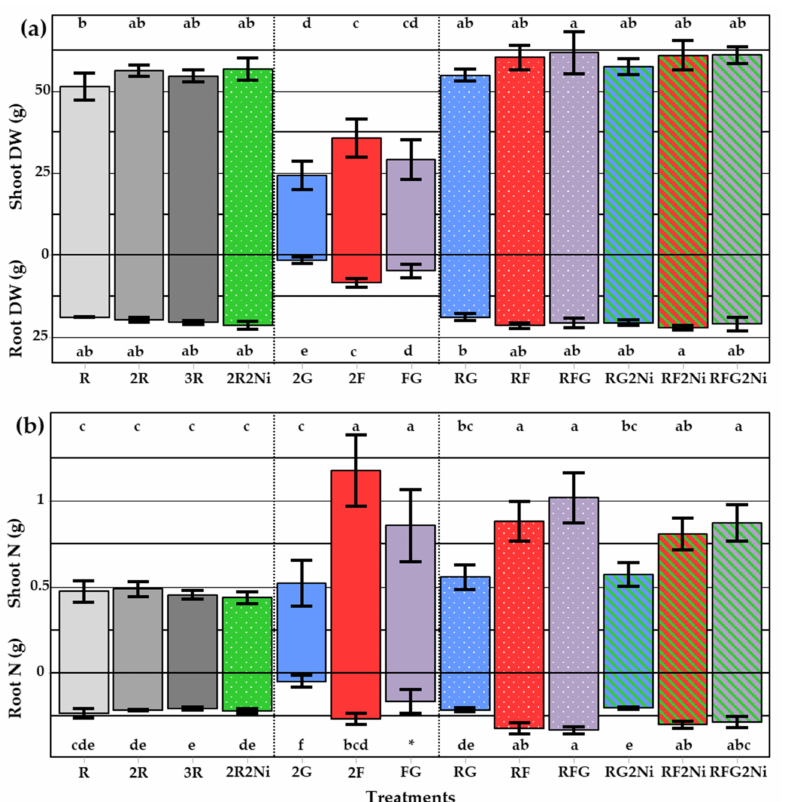
Figure 2. Total shoot and root dry weights (DWs) ( a ) and total shoot and root N ( b ) accumulated per mesocosm. R: OSR ( Brassica napus L. cv Avatar), F: Faba bean ( Vicia faba L. cv Fanfare), G: Grass pea ( Lathyrus sativus L. cv Merkur) and Ni: Niger ( Guizotia abyssinica (L.f.) Cass.). Means of four replicates. Error bars are SDs. For all, one-way ANOVA test p < 0.001. Different letters: a, b, c, d, e indicate significant differences across treatments (Tukey HSD test). *: FG was removed from the root N ANOVA test, see Materials and